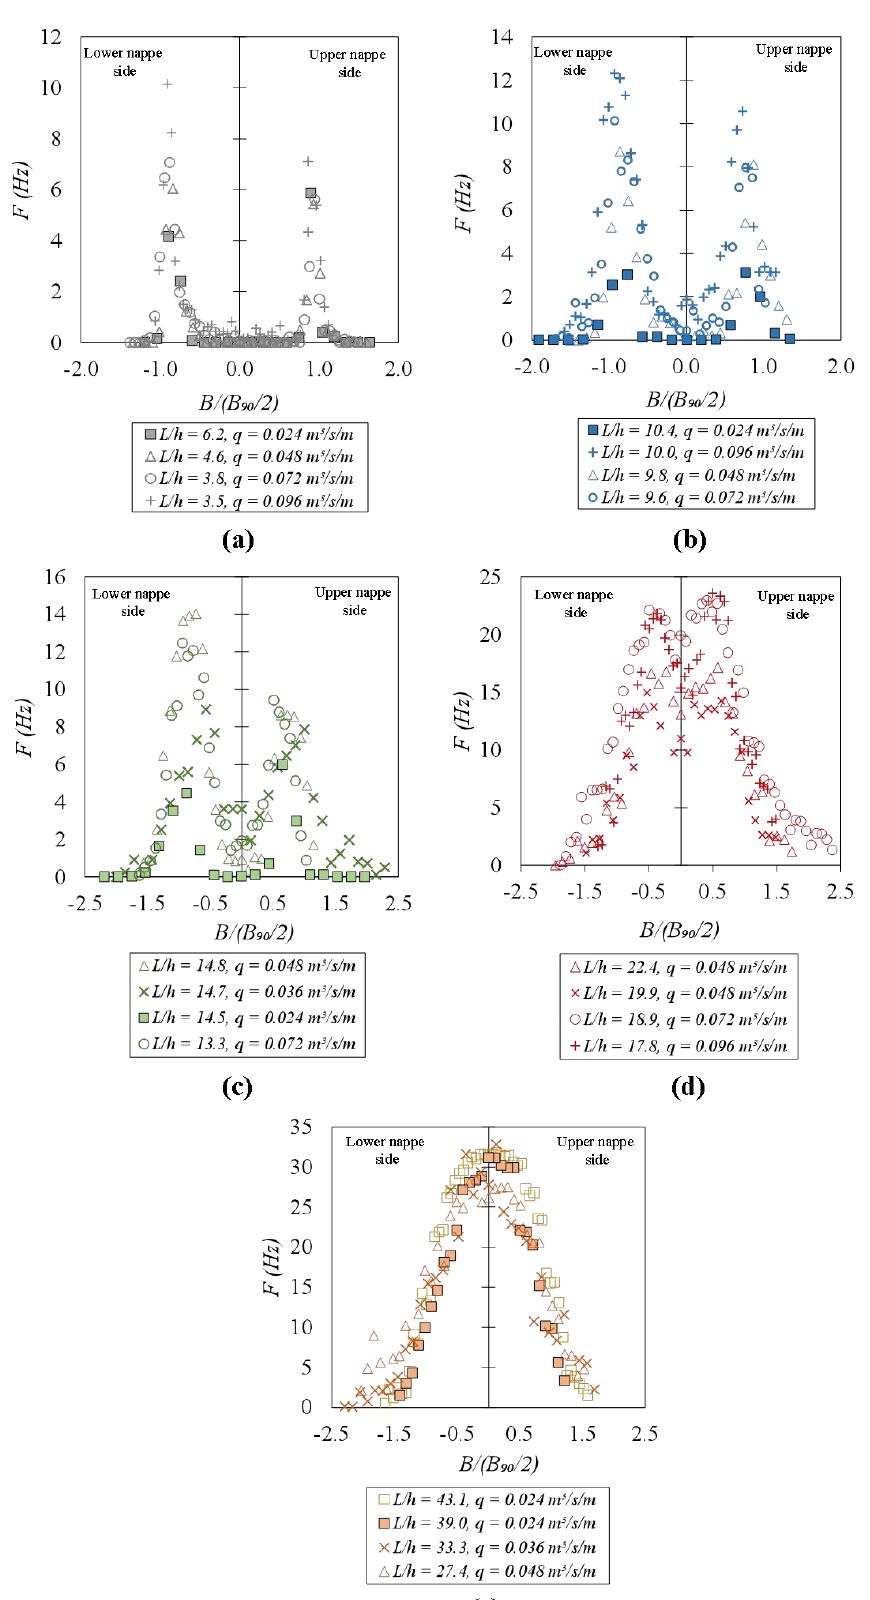
Figure 9. Air–water phase-change count rate as a function of dimensionless jet thickness B /( B 90 /2): ( a ) L/h ratio between 3.5 and 6.2; ( b ) L/h ratio between 9.6 and 10.4; ( c ) L/h ratio between 13.3 and 14.8; ( d ) L/h ratio between 17.8 and 22.4; ( e ) L/h ratio between 27.4 and 43.1.